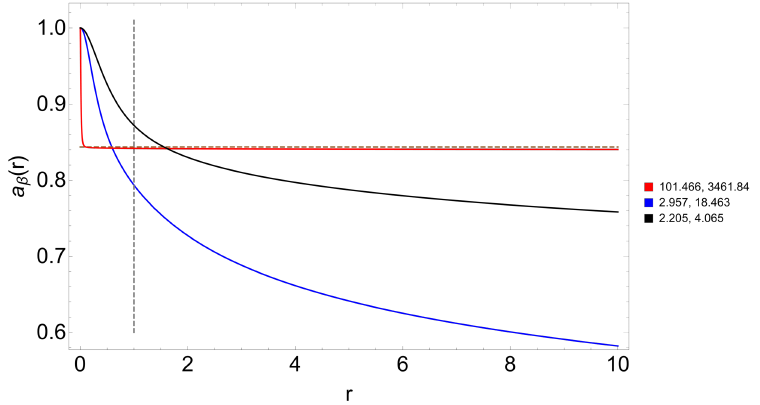
Figure 16. Plot of a β (in the unit of 2 π 2 l − 3 different set of deformations (values of deformations ( A 1 line represents the position of the horizon and the horizontal line represents a β = 27